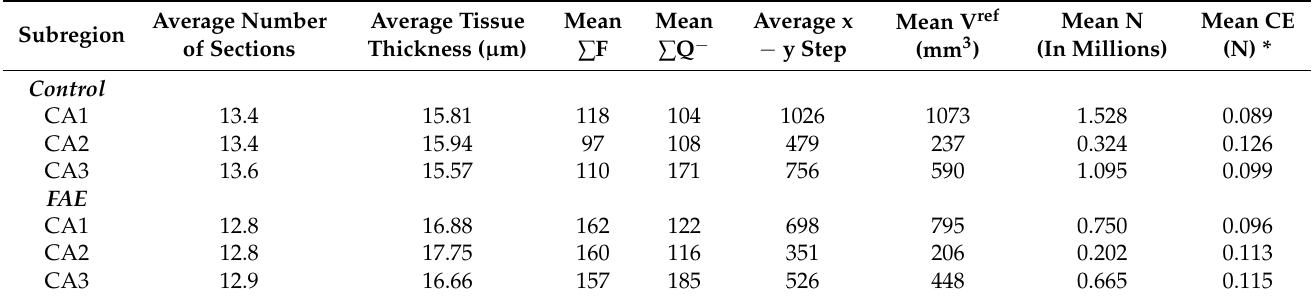
Table 2. Stereology Parameters from unilateral cerebral cortex neuron and volume estimation of control and fetal alcohol-exposed (FAE) monkeys ( Σ Q − total number of neurons sampled; Σ F number of disectors sampled; V cortical gray volume; N total number of neurons CE ( Σ Q − ) coefficient of error for Σ Q; CE ( Σ F) coefficient of error of Σ F; and CE (N) coefficient of error for N). Values are given as mean (CV =